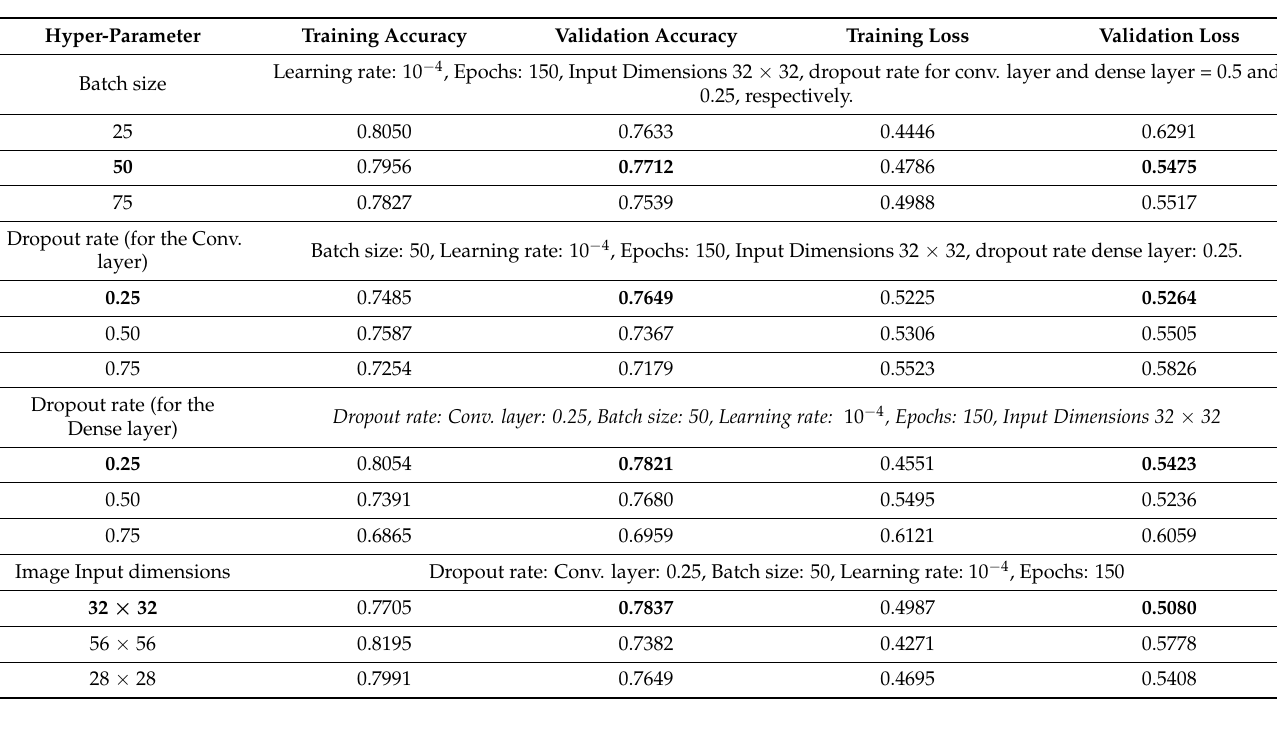
Figure 4. Optimized number of epochs. Table 3. Hyper-parameter